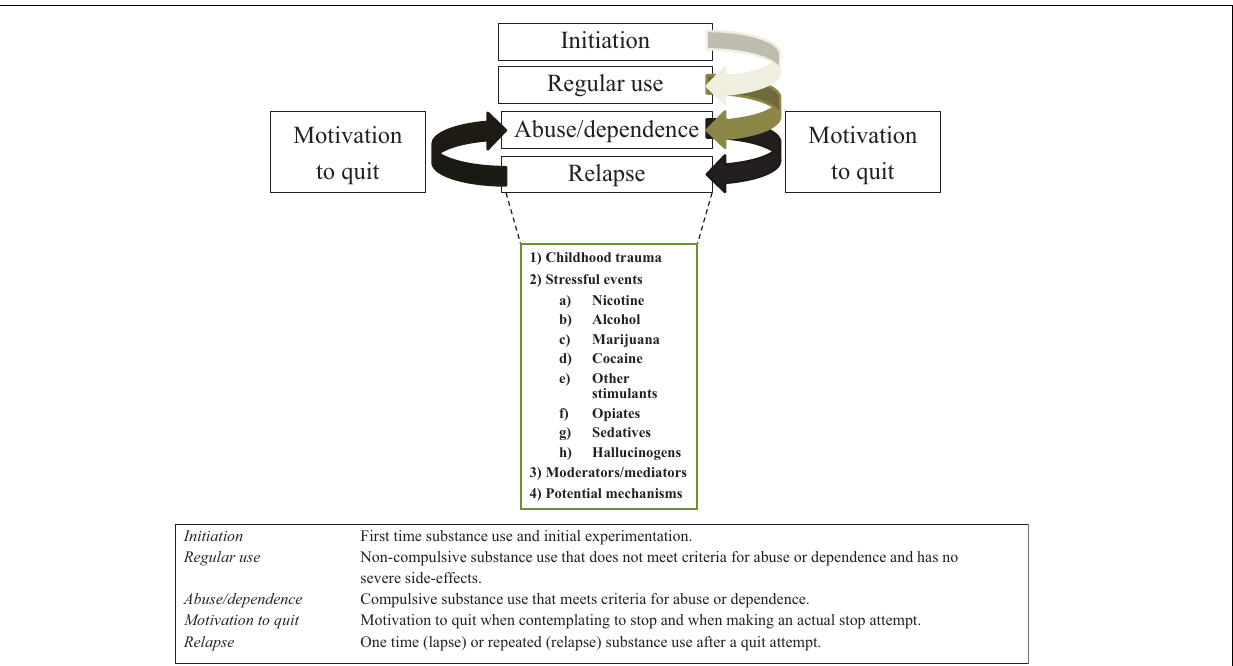
FIGURE 1 | Stages associated with the illness-course of addiction, definitions or each stage, and topics discussed in this review per illness-course stage